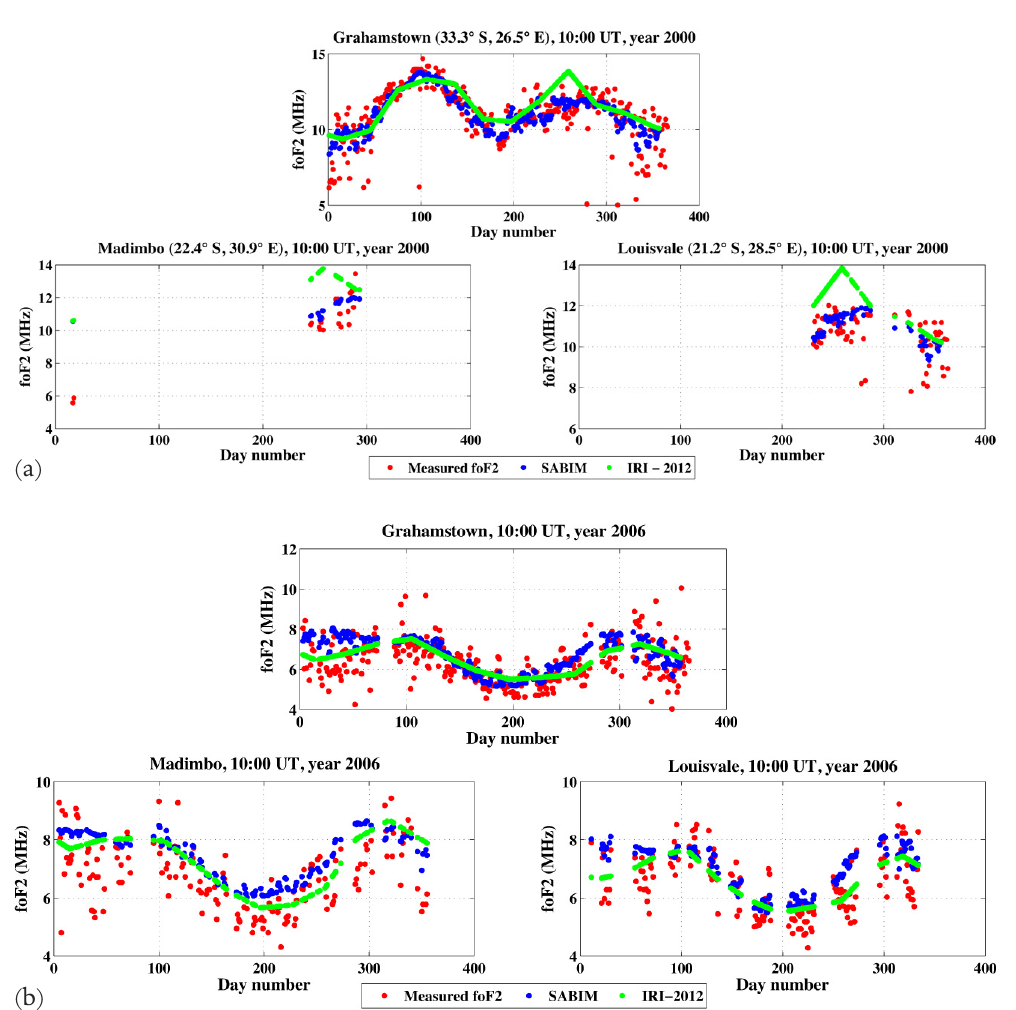
Figure 5. Ionosondes (Grahamstown, Madimbo and Louisvale), SABIM and IRI-2012 10:00 UT foF2 annual variation. (a) During solar max- imum and (b) during solar minimum.